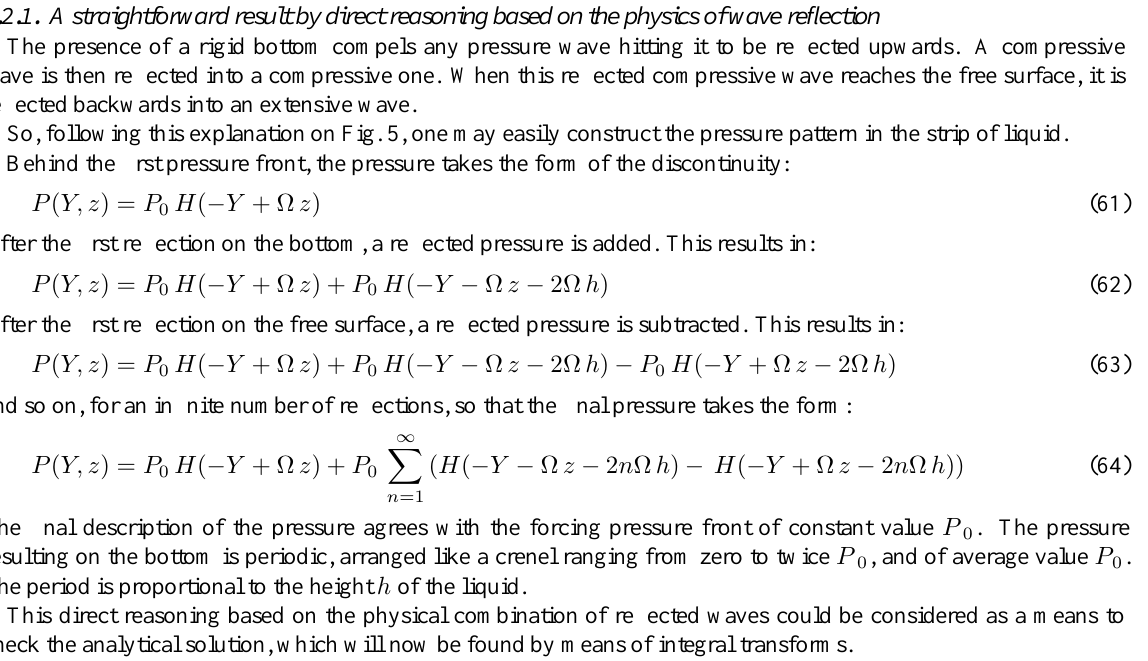
Fig. 5. Acoustic pressure in a strip of liquid loaded by a supersonic stationary pressure